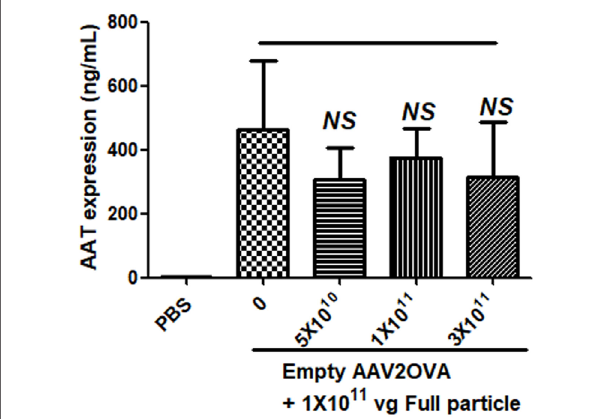
FigUre 7 | No effect of empty virions on transgene expression from adeno-associated virus full particles after systemic administration. Blood was collected from mice in Figure 6 when mice were sacrificed for capsid antigen presentation analysis. Transgene alpha-1-antitrypsin (AAT) expression was detected by enzyme-linked immunosorbent assay. The result is represented as the average and SD of five mice.